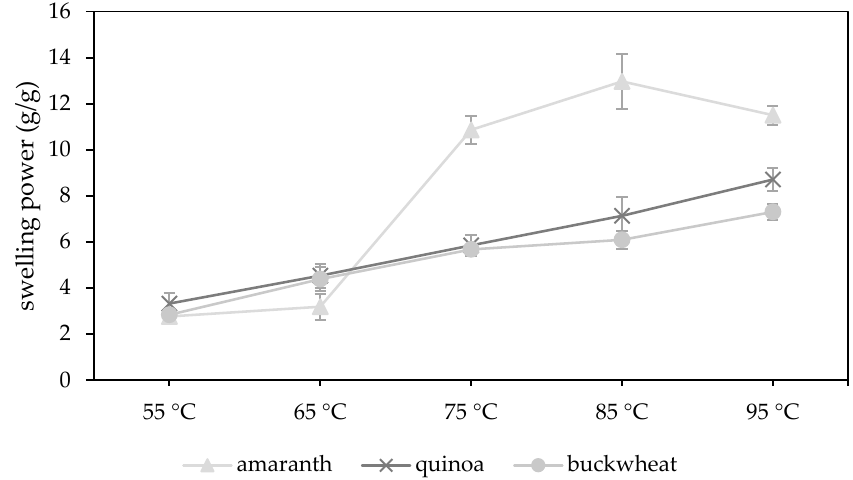
Figure 1. Swelling power (g/g) of amaranth ( n = 8), quinoa ( n = 7) and buckwheat ( n = 10) wholemeal flour measured at different temperatures (55, 65, 75, 85 and 95 °C).